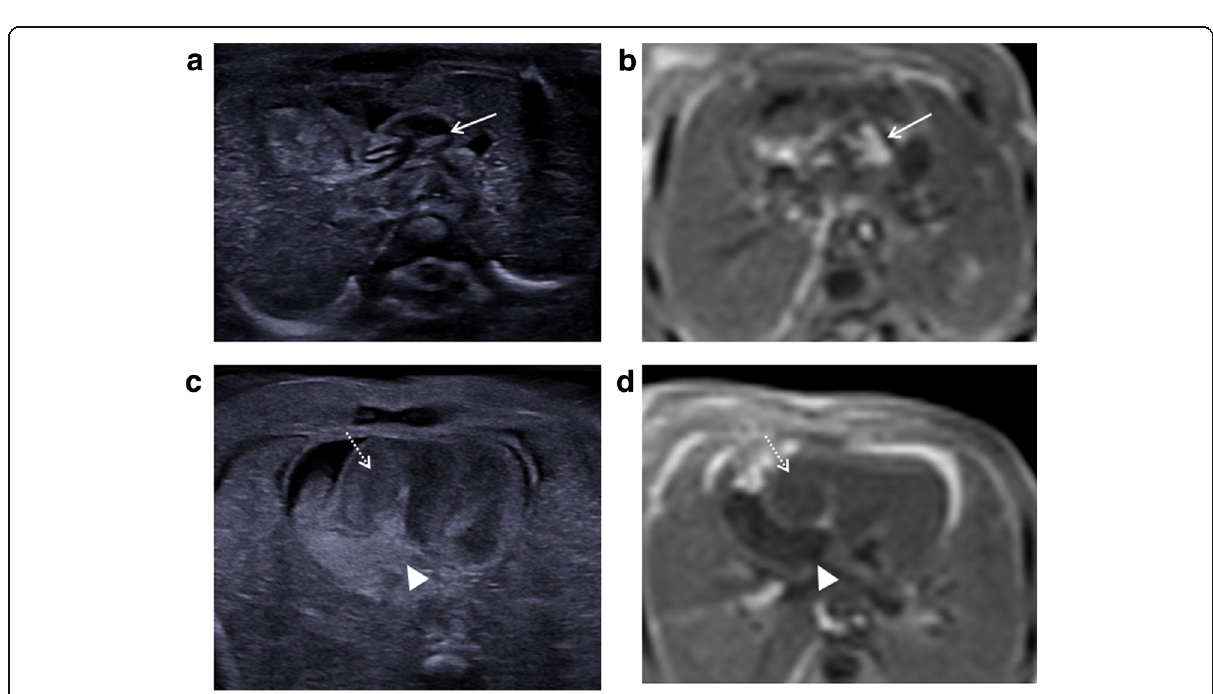
Fig. 10 Supravalvular pulmonary artery stenosis in a foetus at 21weeks gestation. The imaging was performed 5days after termination of pregnancy. Transverse images of the outflow tracts on post-mortem ultrasound ( a ) and T2 weighted MRI at 1.5T ( b ) both demonstrate a dilated main pulmonary artery (solid arrows). The transverse four cardiac chamber view on ultrasound ( c ) and MRI ( d ) show a dilated and thick-walled right ventricle (dotted arrow) and small atrial septal defect (arrowhead). Given the small size of the foetus, the findings were more easily appreciated on ultrasound than